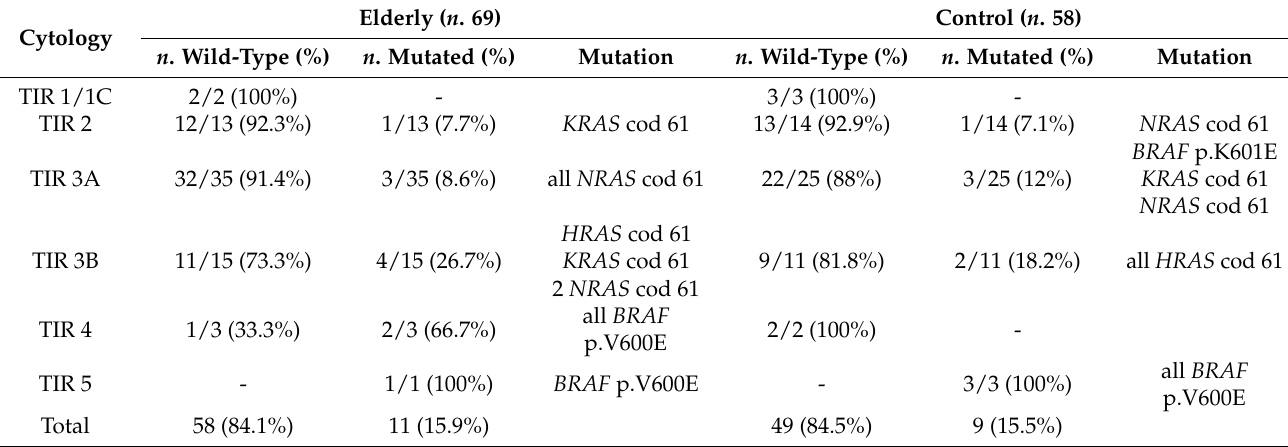
Table 1. Mutational status of elderly and control patients according to cytological diagnostic categories. Elderly ( n . 69) Control ( n . 58) Cytology